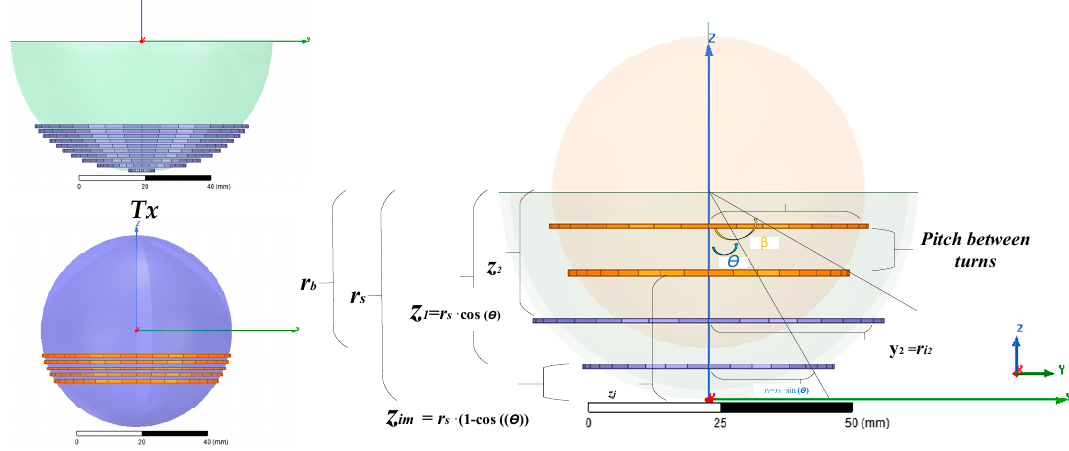
Figure 6. Joint–WPT system in the y-z plane with several variables.